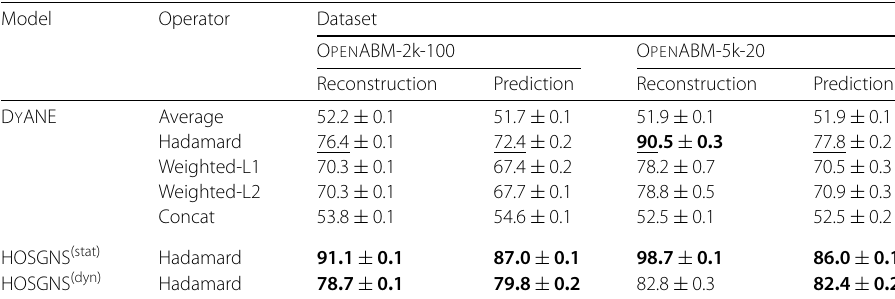
Table 6 Macro-F1 scores in temporal event reconstruction and missing event prediction for synthetic datasets. We highlight in bold the best two scores for each dataset. For baseline model we underline their highest score